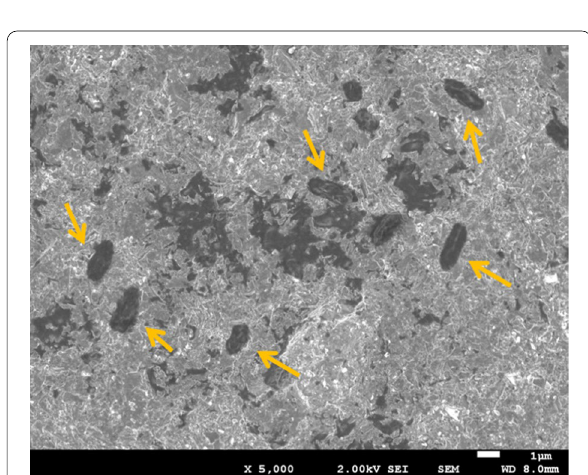
Fig. 7 SEM image of the FPB-2 treated surface 60 min after the adhesion of E. coli . Arrows indicate E.